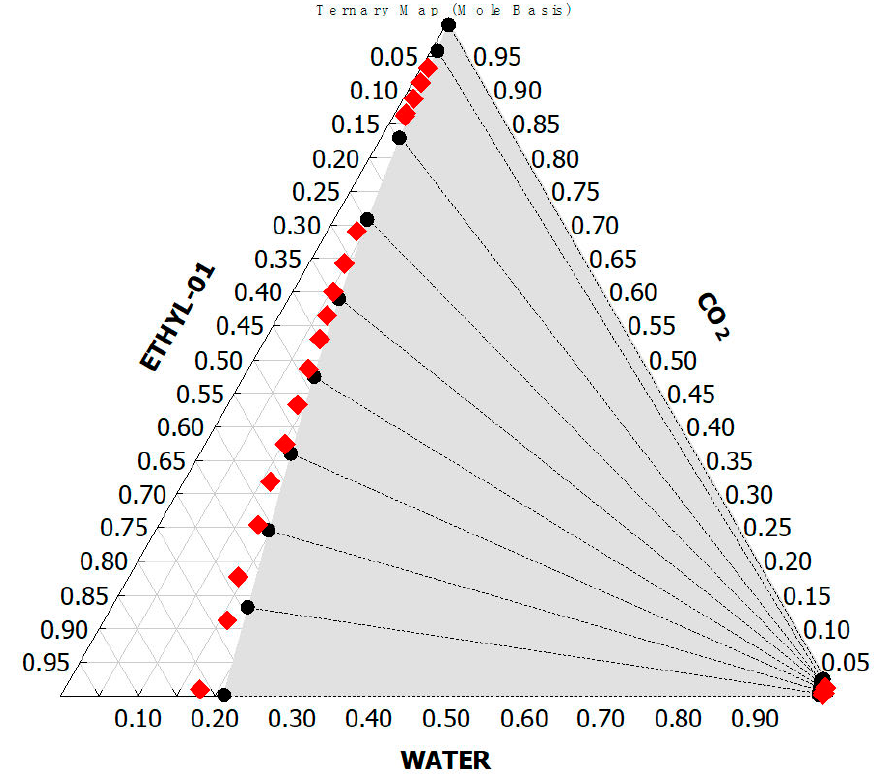
Figure 2. Ternary phase diagram (mol basis) of the system CO 2 –ethyl acetate–water at 8.5 MPa and 37 °C provided by Aspen Plus ® using the PSRK model ( ● ) and compared with experimental phase equilibrium data ( ♦ ) [22].